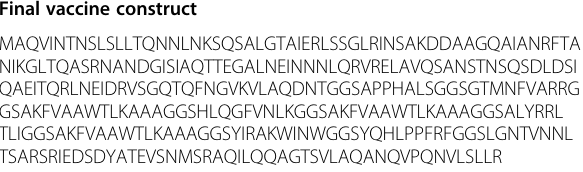
Table 4 The full-fledged vaccine sequence Final vaccine construct